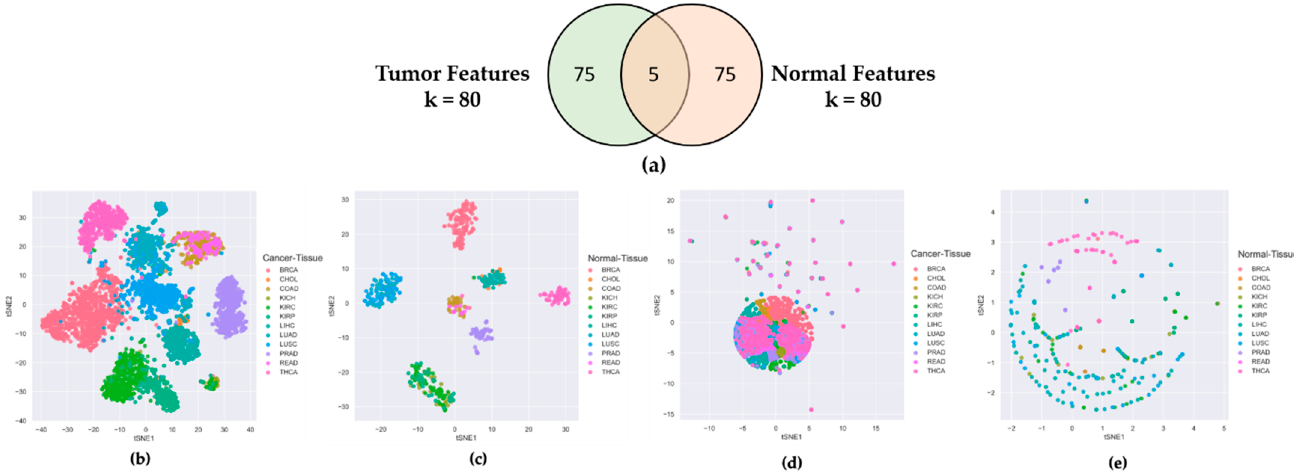
Figure 1. Comparing Tumor Features with Normal Features. ( a ) Venn diagram of 80 tumor features and 80 normal features derived from CAE; ( b ) t-SNE plot of tumor samples using tumor features; ( c ) t-SNE plot of normal samples using normal features; ( d ) t-SNE plot of tumor samples using normal features; ( e ) t-SNE plot of normal samples using tumor features .